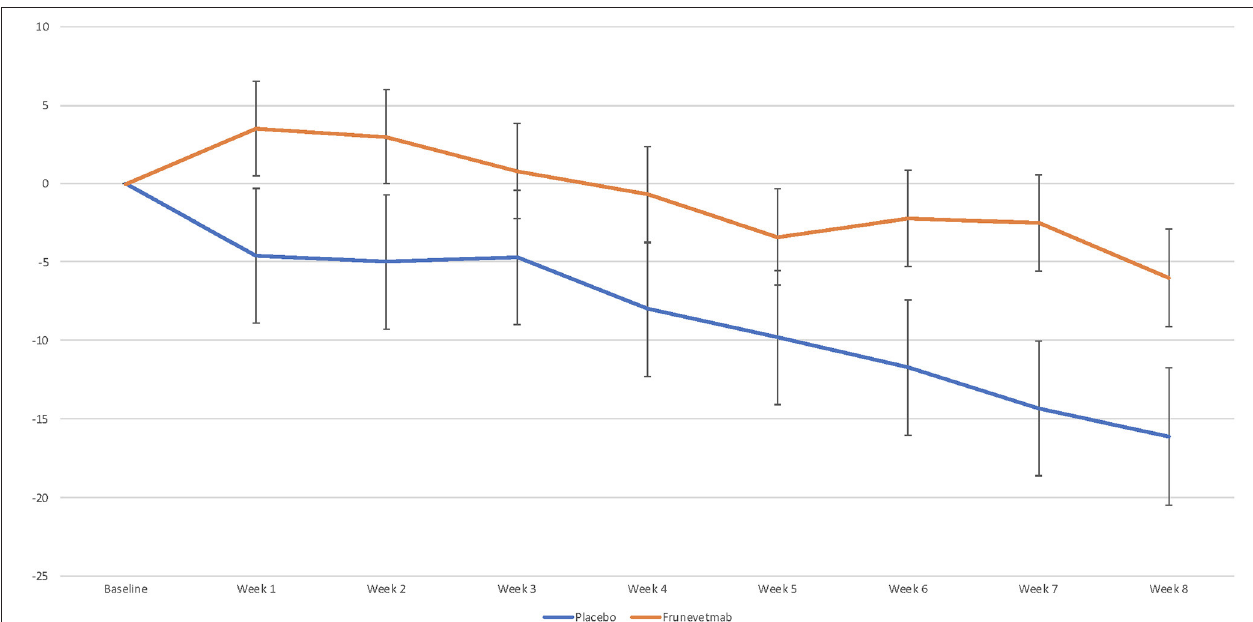
TABLE 4 | Number (percent) success for owner global assessment in each treatment group. Study day Placebo Frunevetmab p -value Day 28 10/38 (26.3%) 41/74 (55.4%) 0.013 Day 56 12/37 (32.4%) 51/70 (72.9%) 0.003 Significant p-values denoted in